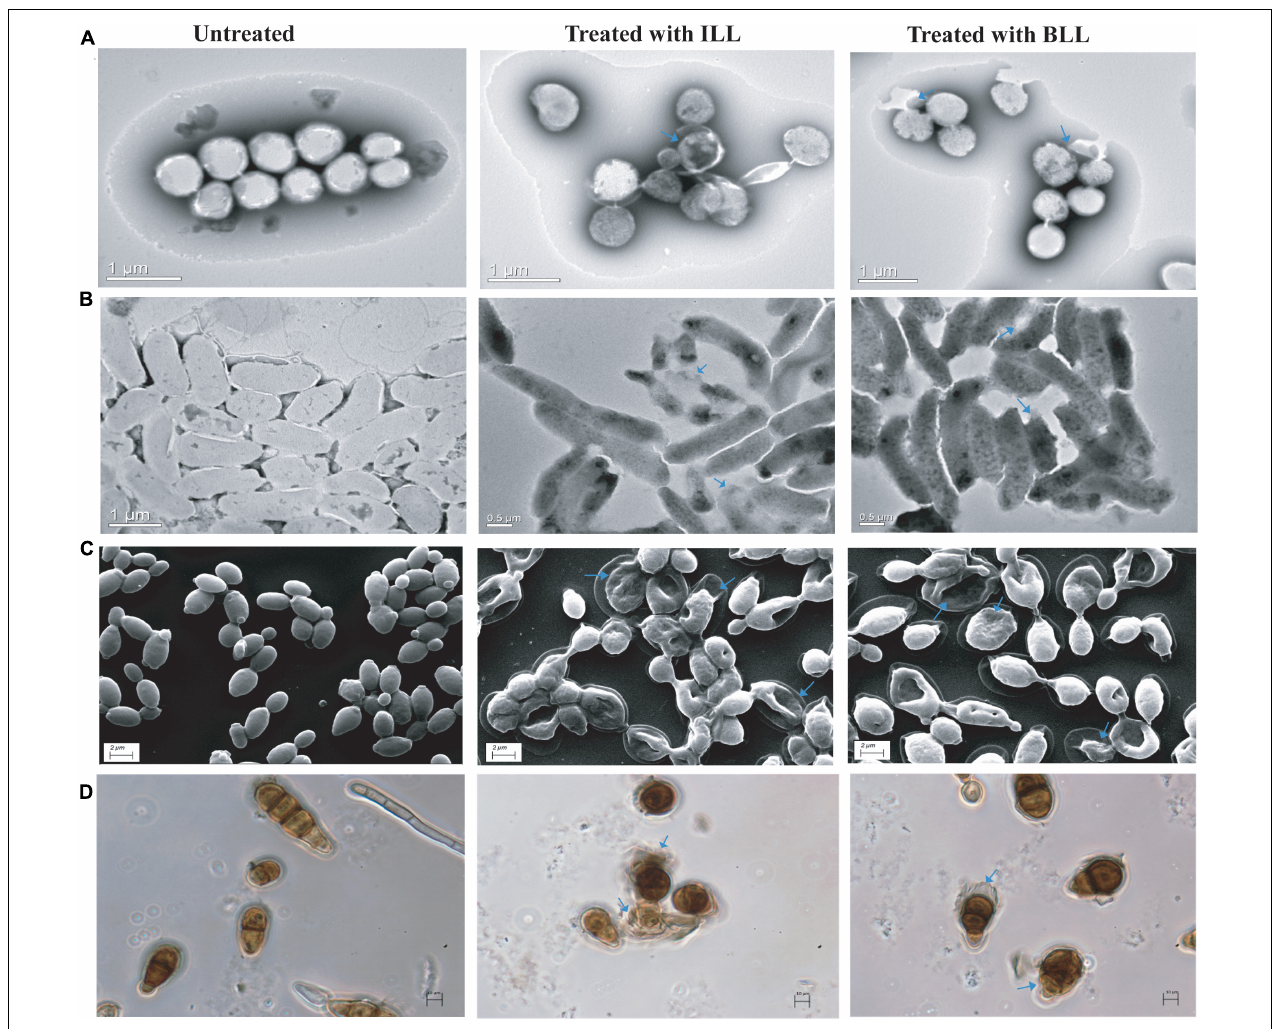
FIGURE 4 | Microscopic examination of indicator strains after treatment with lipopeptides . (A) TEM micrographs of untreated and treated cells of S. aureus MTCC 1430. (B) TEM micrographs of untreated and treated cells of V. cholerae MTCC 3904. (C) SEM micrographs of untreated and treated cells of C. albicans MTCC 183. (D) Phase-contrast images of untreated and treated spores of A. brassicicola MTCC 2102. (Cell damage is marked by